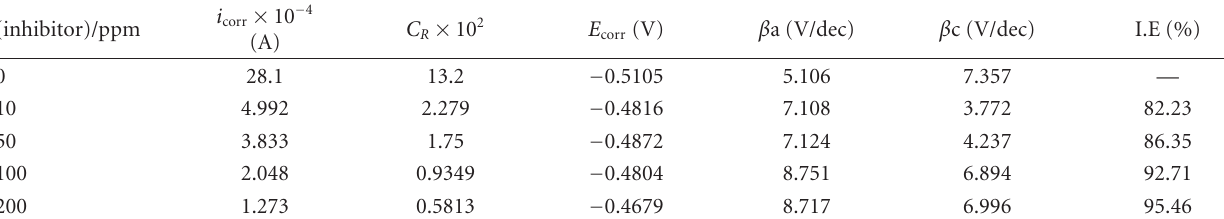
Table 1: Electrochemical parameters of mild steel in 1M HCl solution at 30 ◦ C.